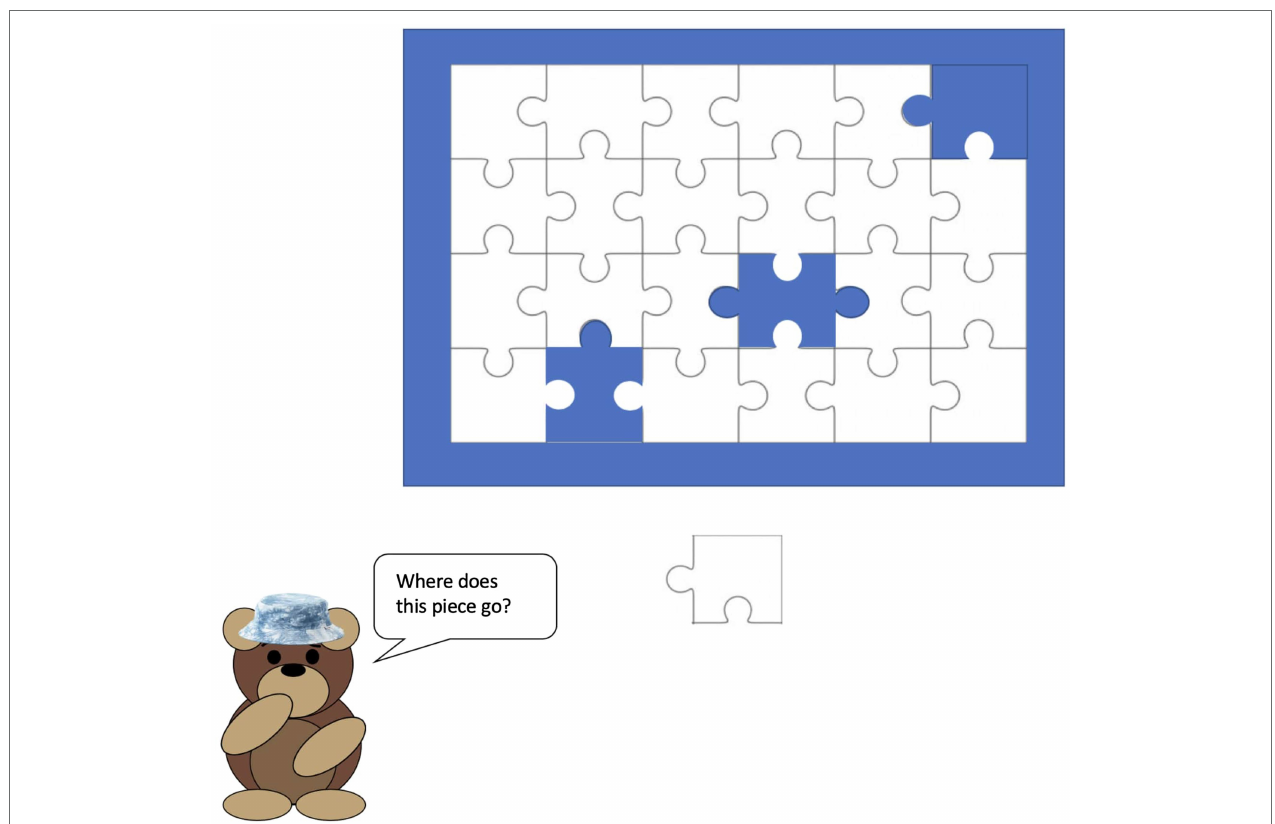
FIGURE 3 | Example trial from the puzzle task.